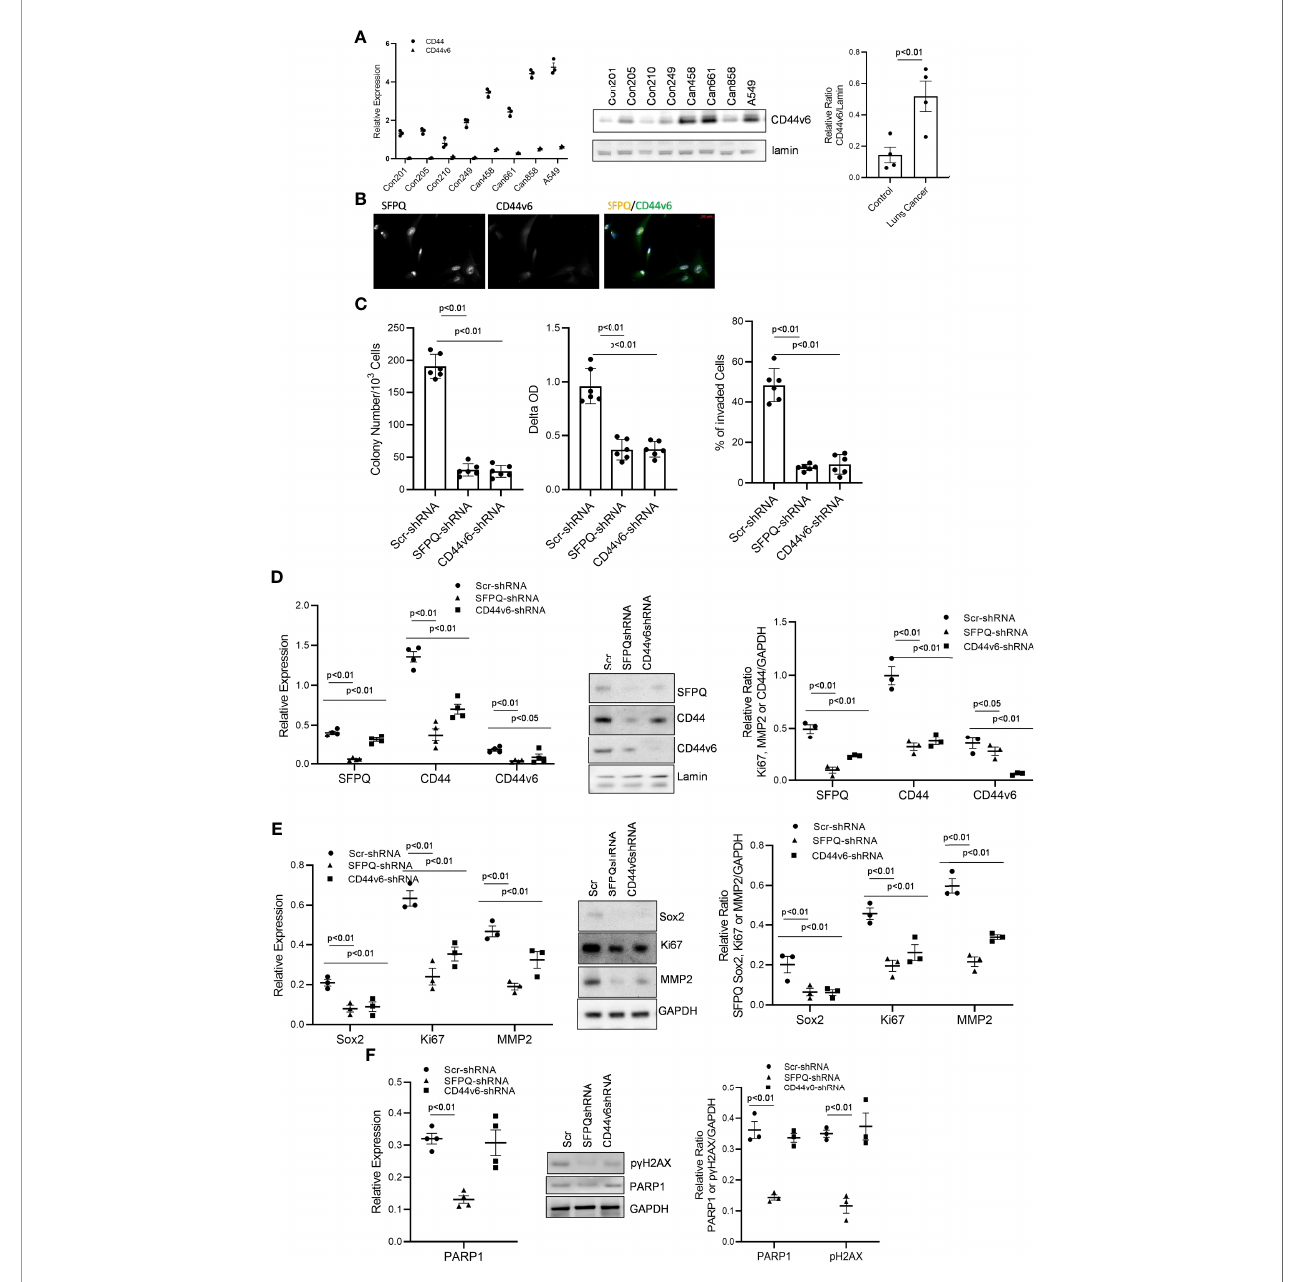
FIGURE 4 | SFPQ promotes the malignant phenotype of lung NSC cancer MSCs via regulating CD44v6 expression. (A) Control and lung NSC cancer MSCs isolated from 4 normal lung cell lines (Con210, Con205, Con215, Con249) and 4 lung NSC cancer cell lines (Can661, Can522, Can838 and A549) were used to evaluate the CD44v6 levels, Which were quanti fi ed with RT-PCR (left, control vs IPF: CD44 p<0.01; CD44v6 p<0.05) and western blot analysis (middle). Densitometry analysis of WB was shown in the right graph. (B) localizations of SFPQ and CD44v6 were analyzed by the confocal microscopy with anti-SFPQ (Abcam, USA) and anti-CD44v6 (Abcam, USA) in lung NSC cancer MSCs. CD44v6 is located in both cytoplasm and nucleus. Scale Bar=20µm. (C – E) Lung NSC cancer MSCs isolated from A549 and Can 661 cell lines were transduced with scramble or SFPQ shRNA or CD44v6 shRNA Lenti virus for 48 hours, and the cells were used for following analysis: (C) Colony Assay (left), Cell proliferation assay (middle) and Cell invasion assay (right). Colony number, cell proliferation rate and invaded cells in lung NSC cancer MSCs transduced with SFPQ shRNA or CD44v6 shRNA were reduced when compared with the control group. (D) SFPQ, CD44, and CD44v6 levels were analyzed by RT-PCR (left) and western blot analysis (middle) on the same cell groups. Densitometry values are shown in the right hand graph. (E) Expression levels of Sox2, Ki67 and MMP2 were analyzed with RT-PCR (left) and western blot analysis (middle) on the same cell groups. Densitometry analysis was shown in the graph on the right. (F) mRNA level of PARP1 was analyzed with RT-PCR (left), and western blot analysis (middle) of PARP1 protein and phosphorylated g H2AX were conducted on the same cell groups. Densitometry analysis was shown in the right graph. All data are shown as mean ± S.E. ( n =3 independent